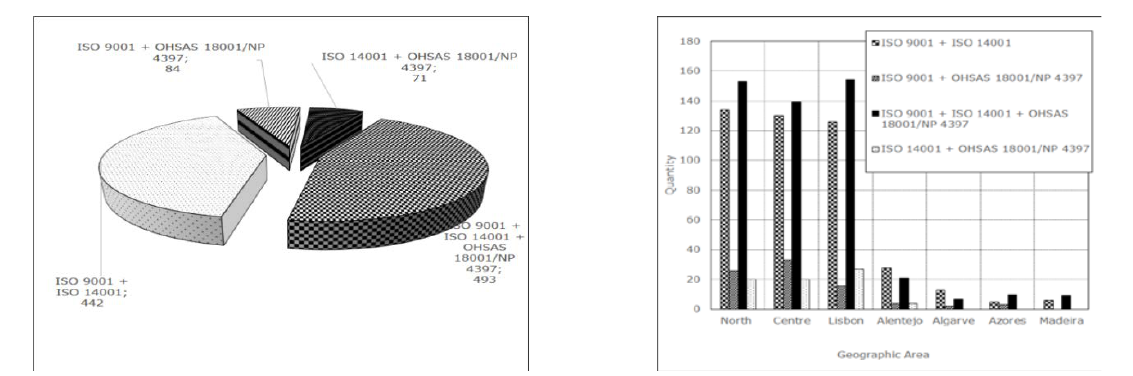
Figure 1. Portuguese IMSs (Breakdown by typology). Figure 2. Portuguese IMSs (Breakdown by geographic